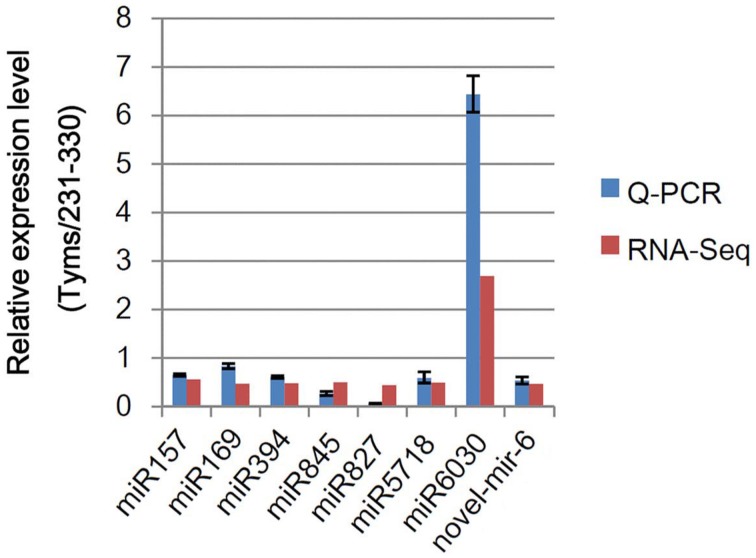
Q-PCR analysis of the relative expression levels of miRNAs. The bars indicate the SE; four biological and three technique replicates were performed.